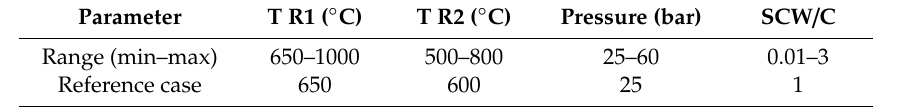
Table 2. Reference conditions used in the sensitivity analysis.